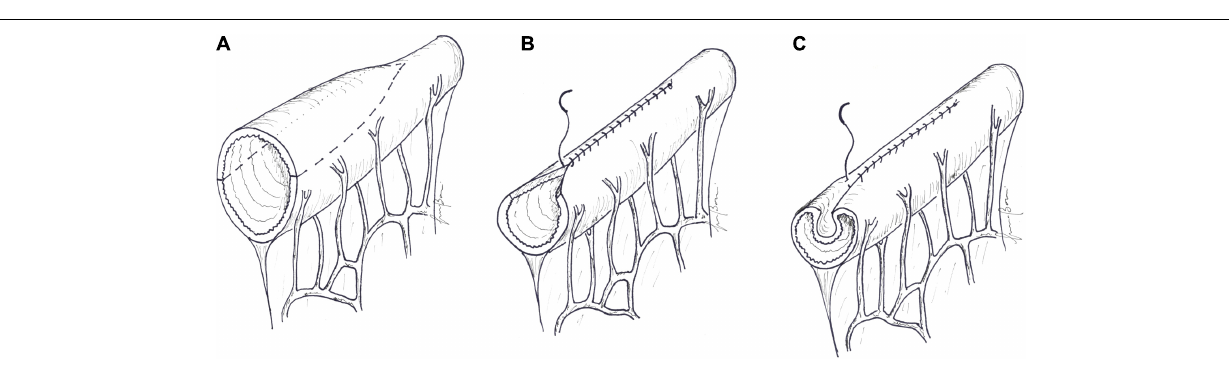
a bowel elongation technique (60). A six-week-old boy had an ultra-short bowel due to intrauterine midgut volvulus, with the remnant bowel only represented by the dilated duodenum